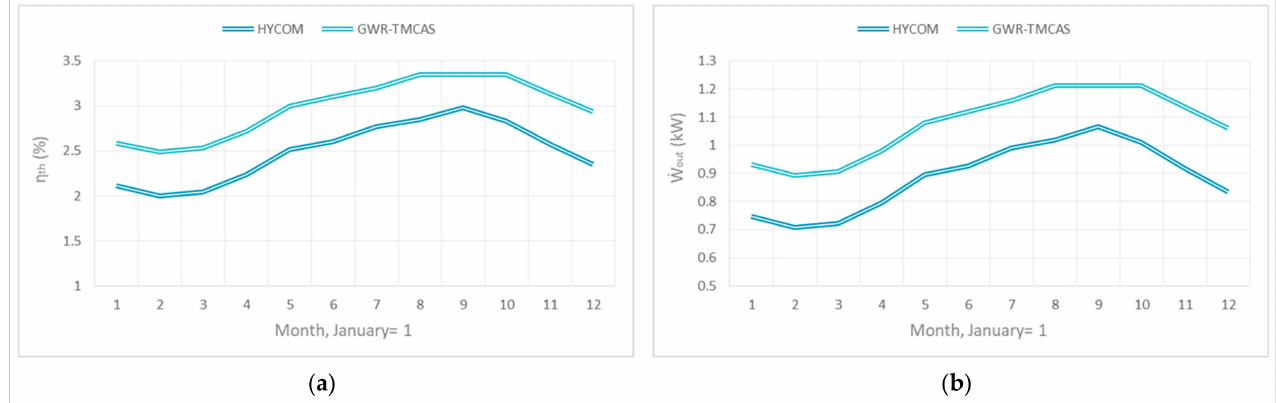
Figure 8. Maximum thermal efficiency ( a ) and maximum power output ( b ) for OTEC-CC-MX-1 kWe using minimum working fluid mass flow using HYCOM and GWT-TMCAS temperature